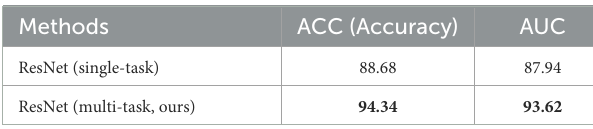
TABLE 2 Quantitative comparisions of the effectiveness of multi-task framework.